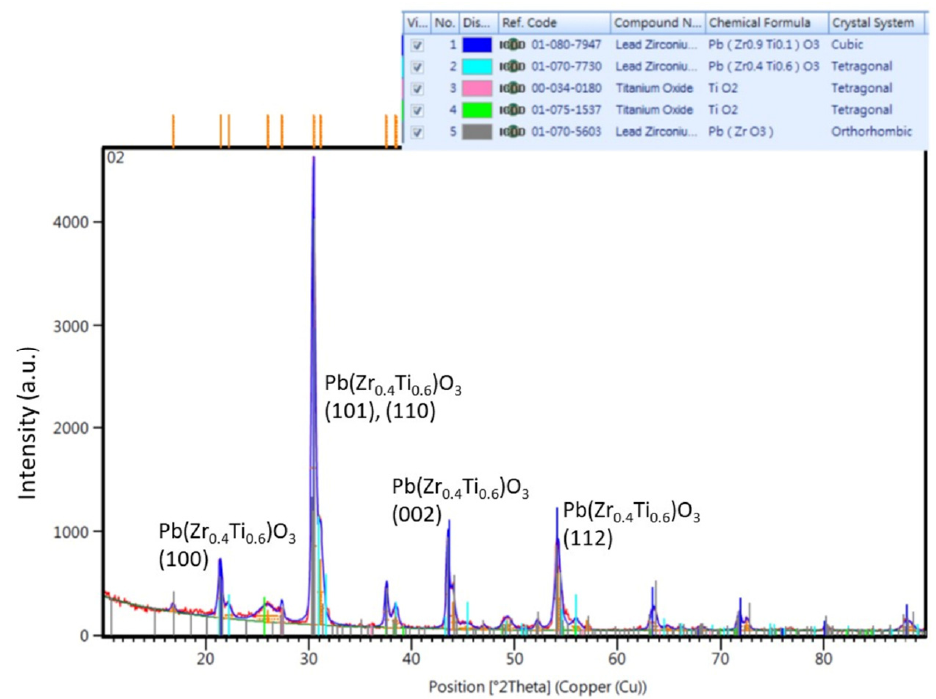
Figure 5. The XRD results of the fabricated PZT